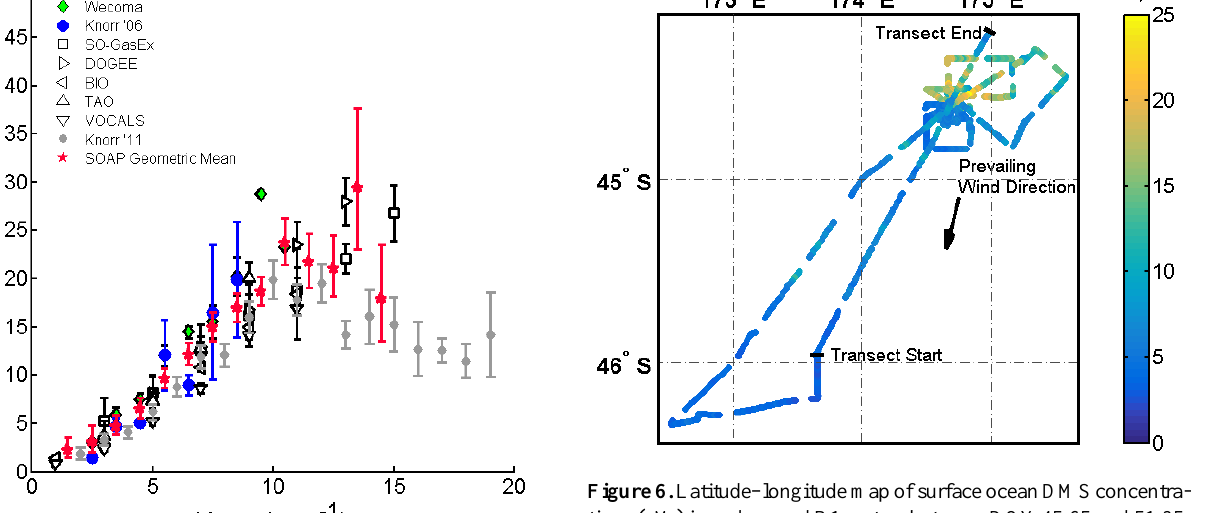
Figure 6. Latitude–longitude map of surface ocean DMS concentra- tions (nM) in and around B1 waters between DOY45.65 and 51.35. Start and end points of the transect into B1 are indicated. The arrow indicates the prevailing wind direction along the